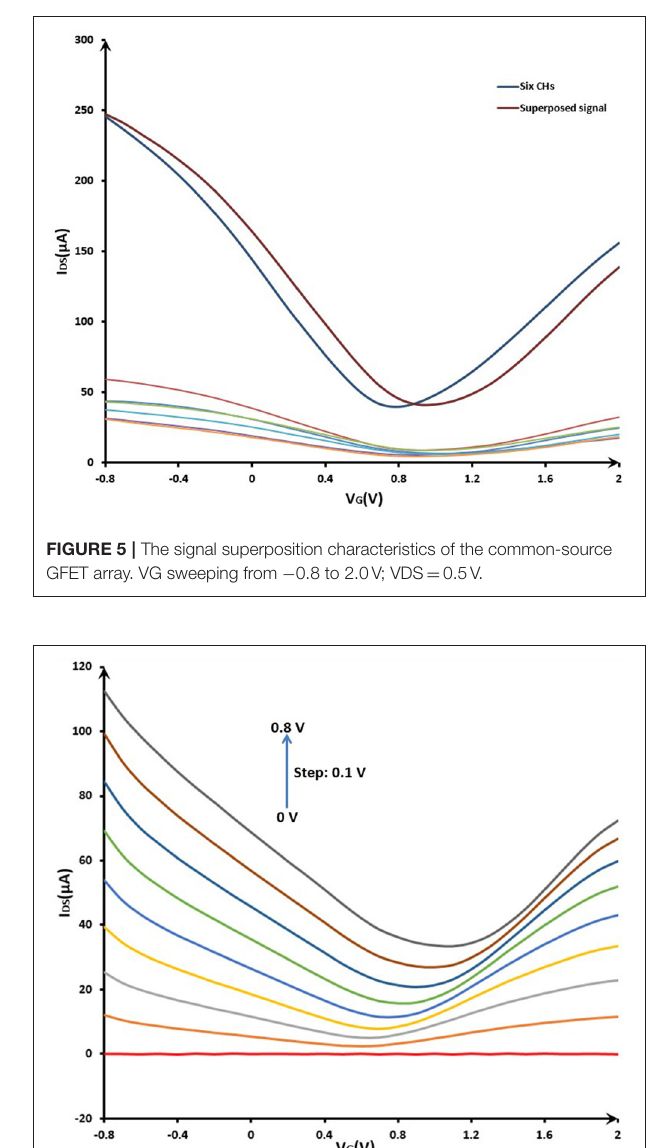
Frontiers in Chemistry |